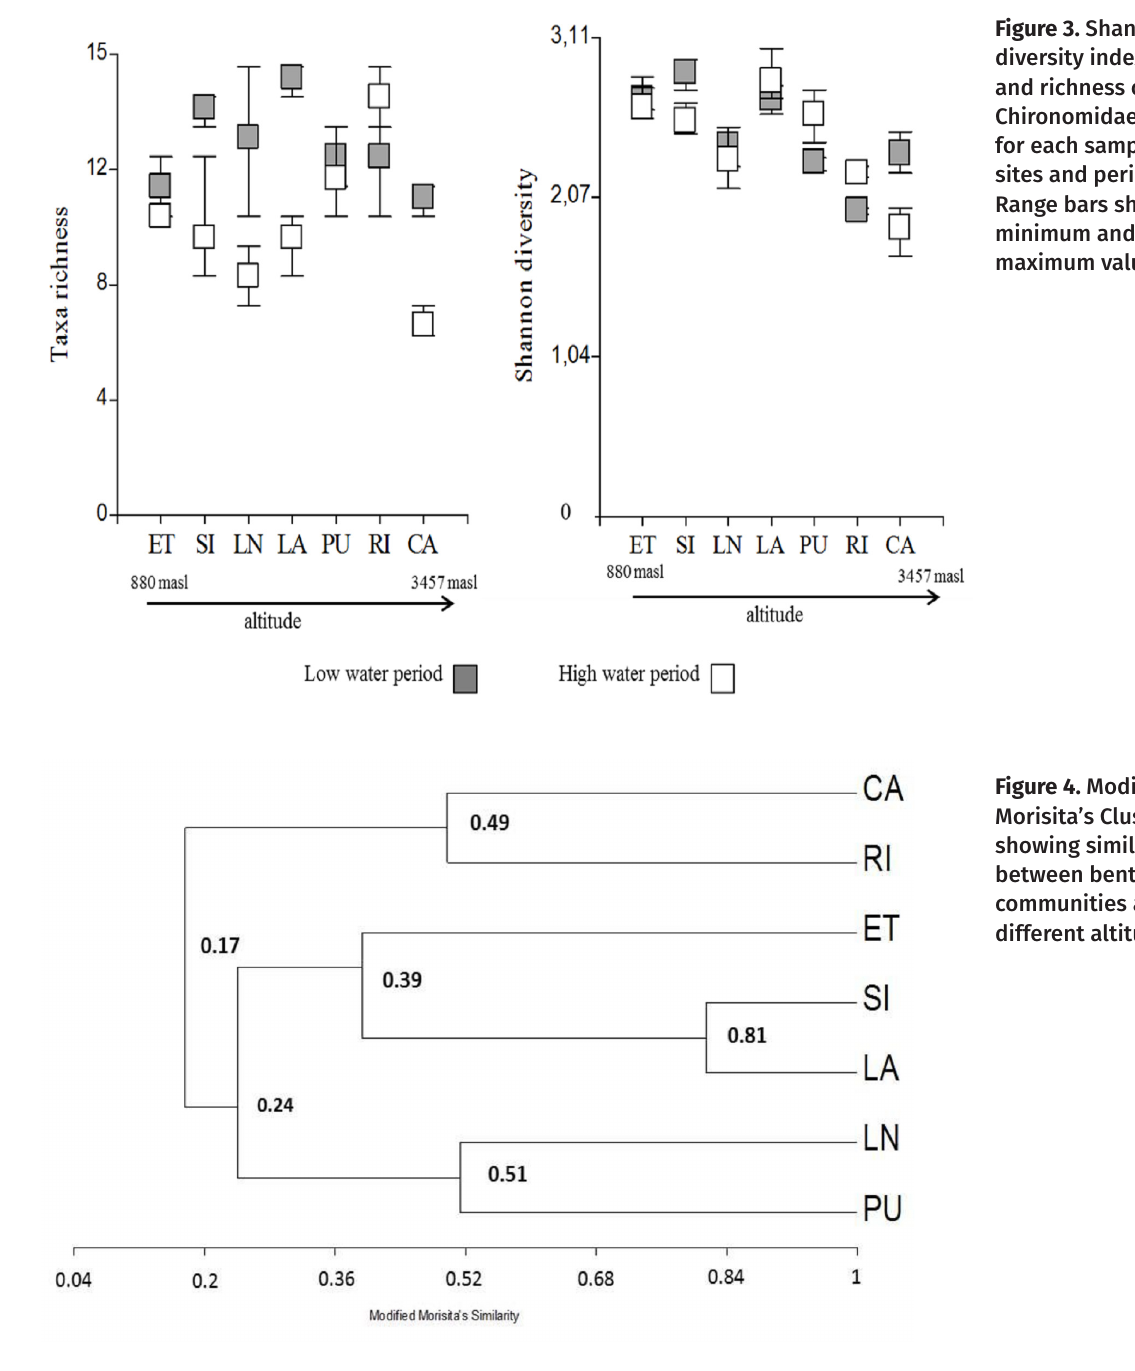
Morisita’s Cluster showing similarity between benthic communities at different